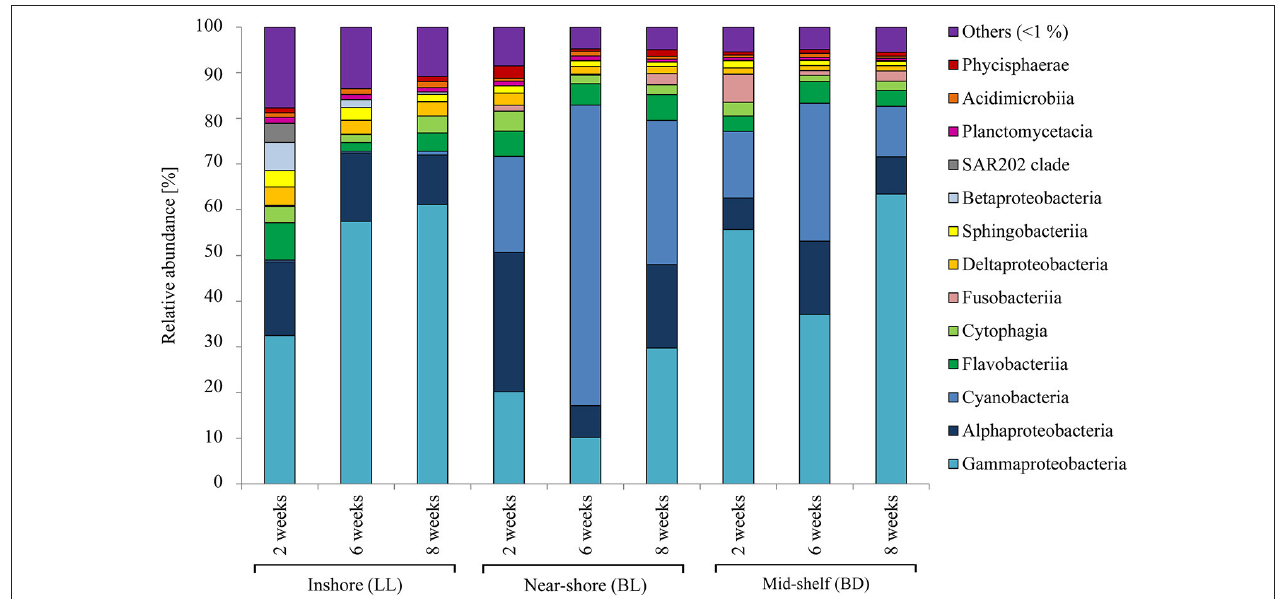
FIGURE 7 | Relative abundance of bacterial classes on artificial ceramic tiles. Bacterial communities were sampled on tiles after 2, 4, 6, and 8 weeks exposure in the reef at three sites; inshore (LL), near-shore (BL) and mid-shelf (BD). Bacterial communities on lower tiles facing down are presented, for full range of all tiles see Figure S4.